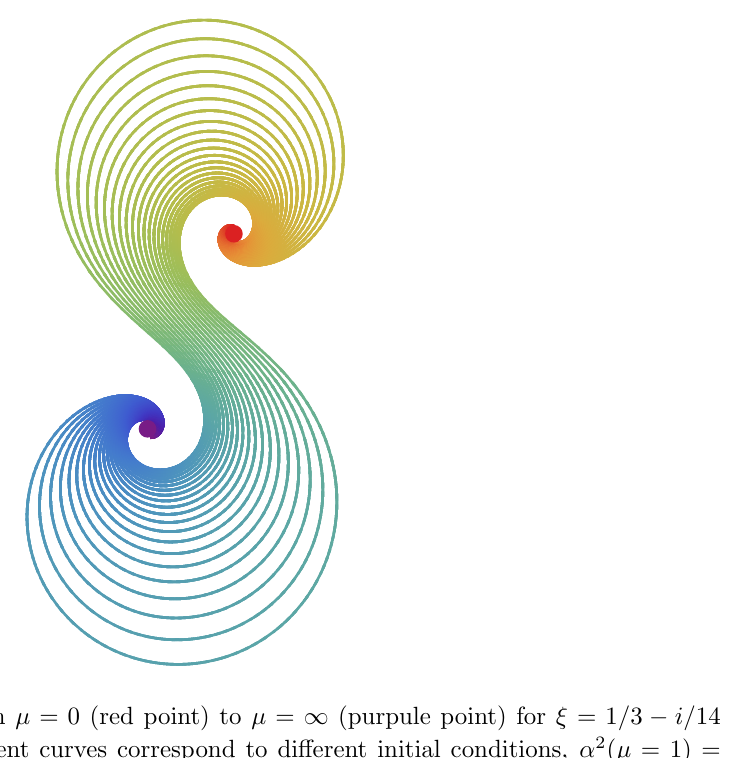
Figure 19 . Flow of (cid:11) 2 ( (cid:22) ) from (cid:22) = 0 (red point) to (cid:22) = 1 (purpule point) for (cid:24) = 1 = 3 (cid:0) i= 14 on a complex (cid:11) 2 (cid:0) plane. Di(cid:11)erent curves correspond to di(cid:11)erent initial conditions, (cid:11) 2 ( (cid:22) = 1) = (cid:0) 0 : 1 + 0 : 01 k with k = 0 ; 1 ; : : : ;